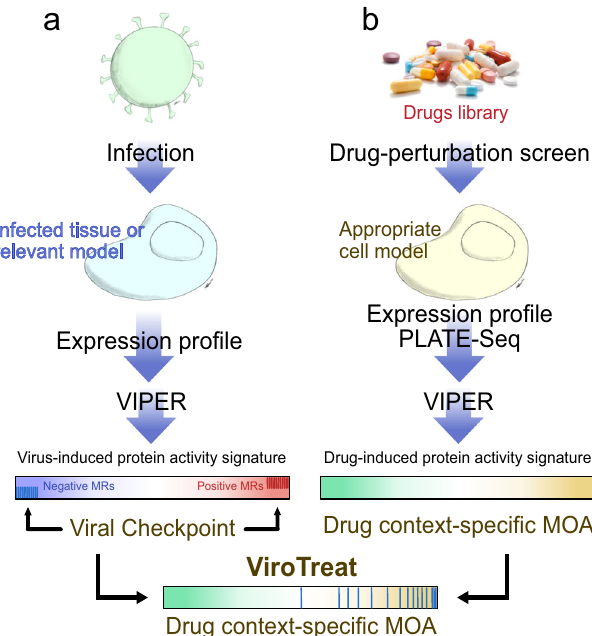
Fig. 2 Schematic representation of the ViroTreat algorithm. a Virus- induced MR proteins — the Viral Checkpoint — dissected by VIPER analysis of a gene expression signature, obtained by comparing an infected tissue or relevant model with non-infected mock controls. b Context-speci fi c drug MoA database, generated by perturbing an appropriate cell model with therapeutically relevant drug concentrations, followed by VIPER analysis of the drug-induced gene expression signatures to infer the drug-induced protein activity signature. ViroTreat prioritizes drugs able to activate the Viral Checkpoint ’ s negative MR proteins by quantifying the enrichment of such proteins on the drugs ’ context-speci fi c